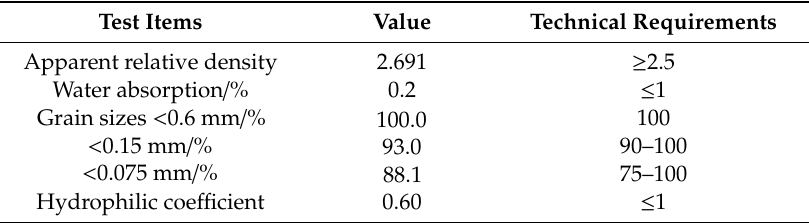
Table 4. Physical Properties of Mineral